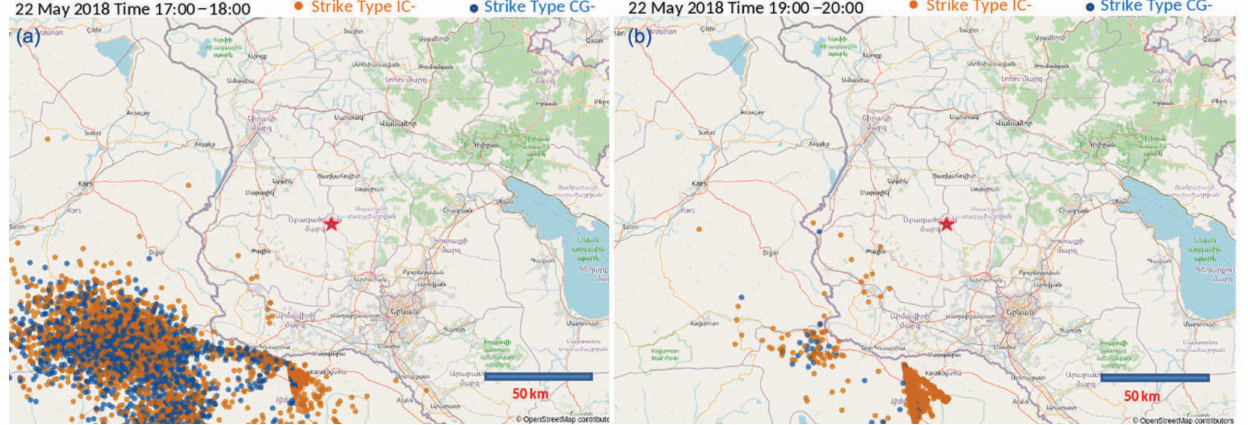
Figure 3. Map of lightning flashes obtained with Boltek’s storm tracker on 22 May 2018, before TGE at 17:00–18:00 ( a ); and during TGE at 19:00–20:00 ( b ). The lightning type symbols and storm duration are portrayed in the upper panel, and the location of the Aragats research station is denoted by a red